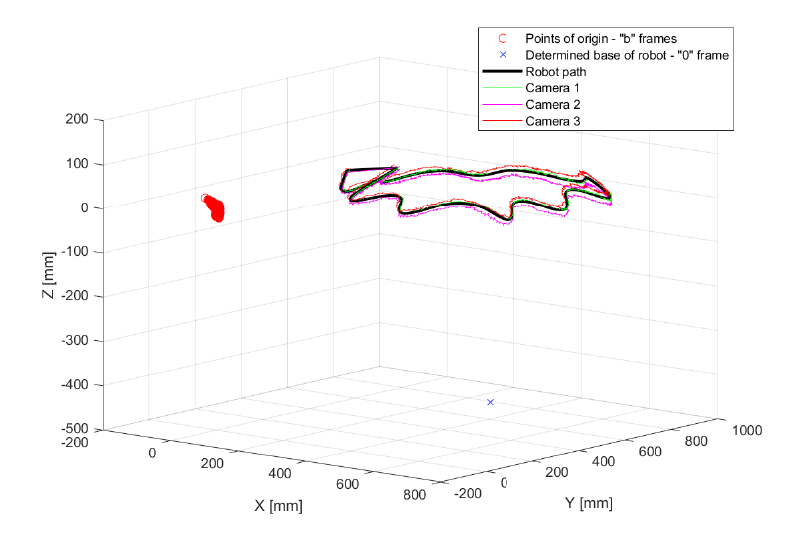
Figure 7. Measured path in comparison with the real robot path of simulation B.